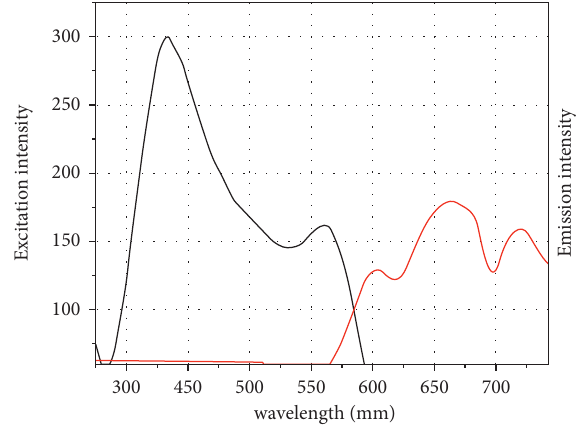
Figure 6: Emission (right; λ λ em � 650nm) spectra of coumarin 3 (1 × 10 − 5 M) in a 10% etha- nolic-universal buffer solution with a pH of 4.